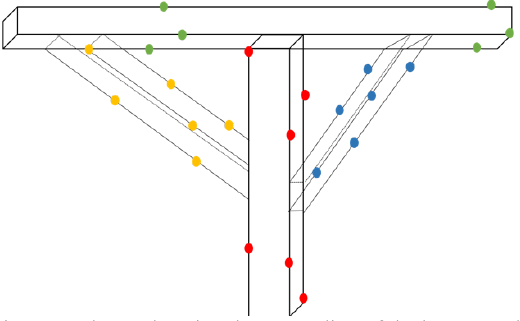
Figure 3. Castle of Haut-Kœnigsbourg.